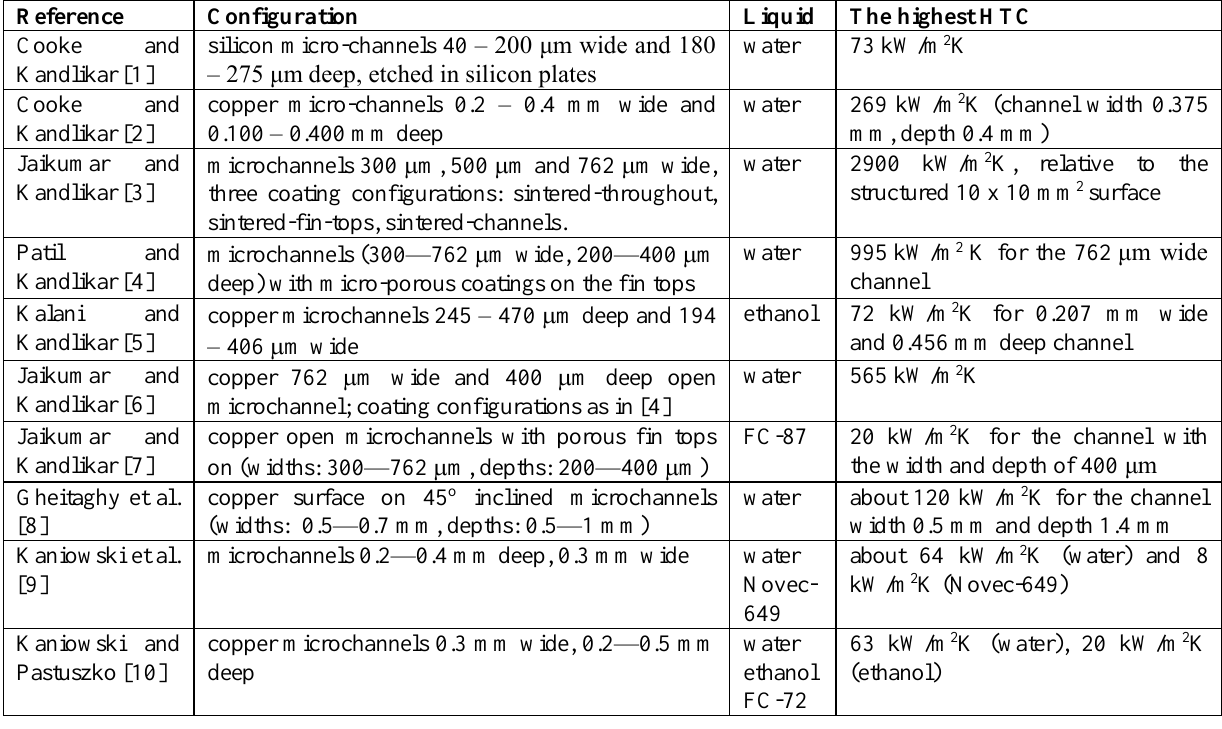
Table 1. Types of open microchannels for pool boiling enhanced heat